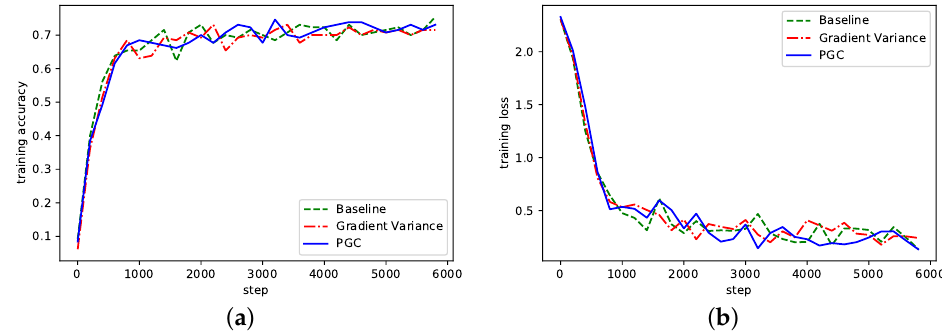
Figure 6. ( a ) Accuracy in LeNet network on MNIST; ( b ) Loss curve in LeNet network on MNIST. According to the curve fluctuation in Figure 6, it can be seen that the adaptive com- pression algorithm based on gradient partition could also achieve normal convergence. as shown in Figures 7 and 8.